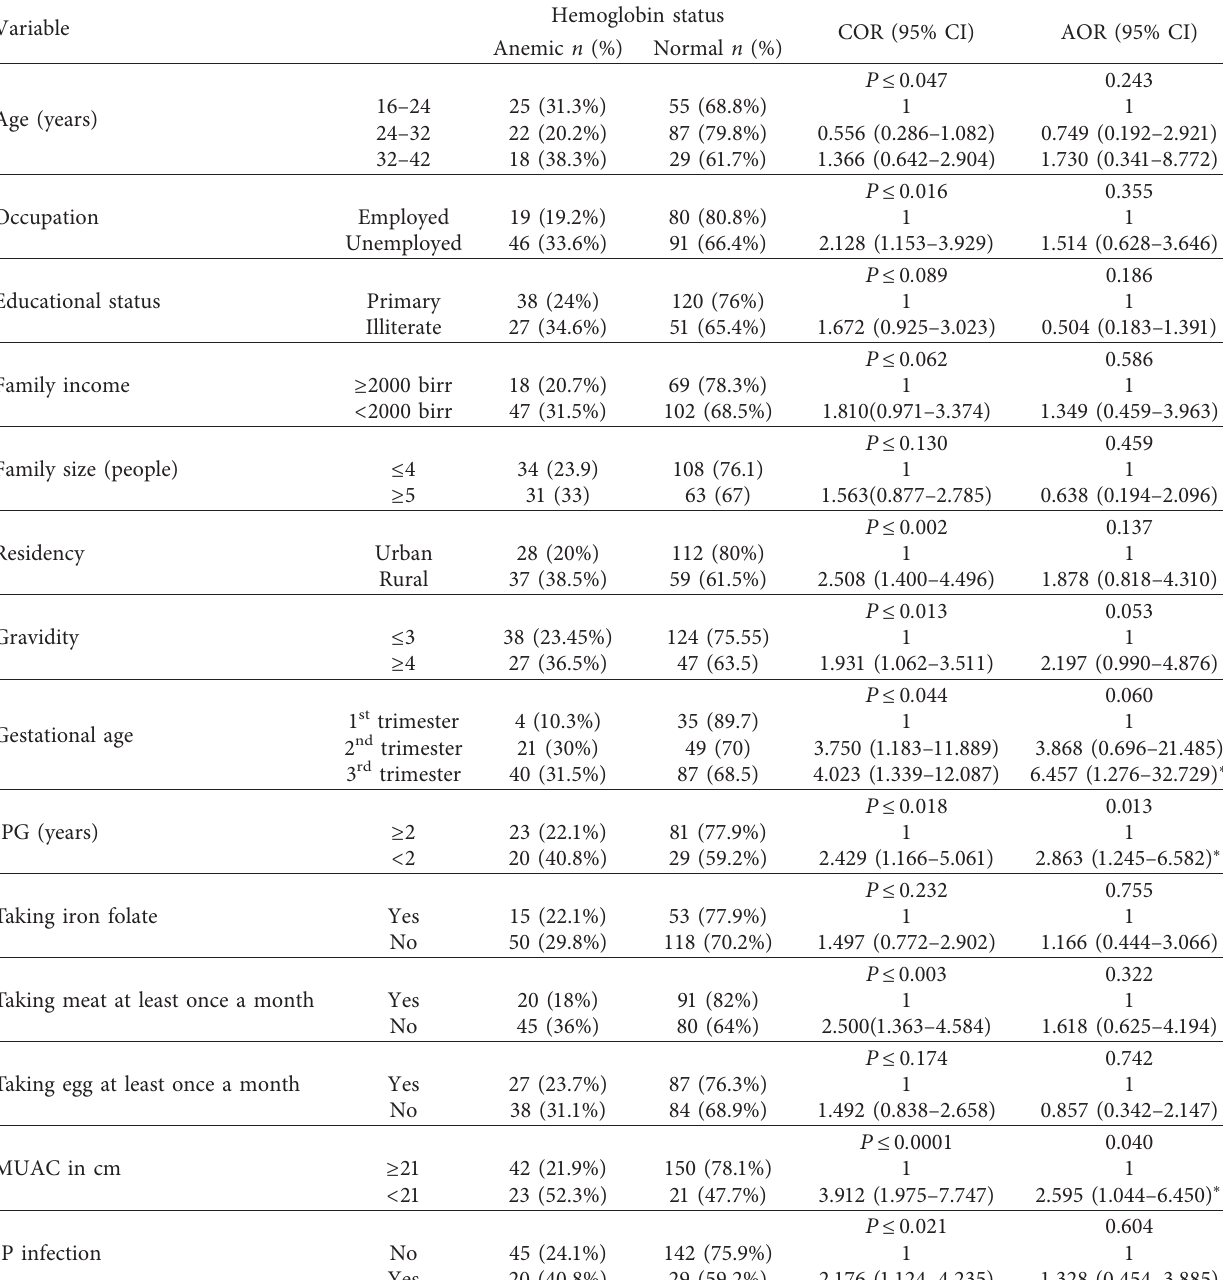
Table 4: Bivariate and multivariate analysis of anemia and related factors among study participant in a Kulito Health Center, SNNPR, Ethiopia, 2018 ( n �